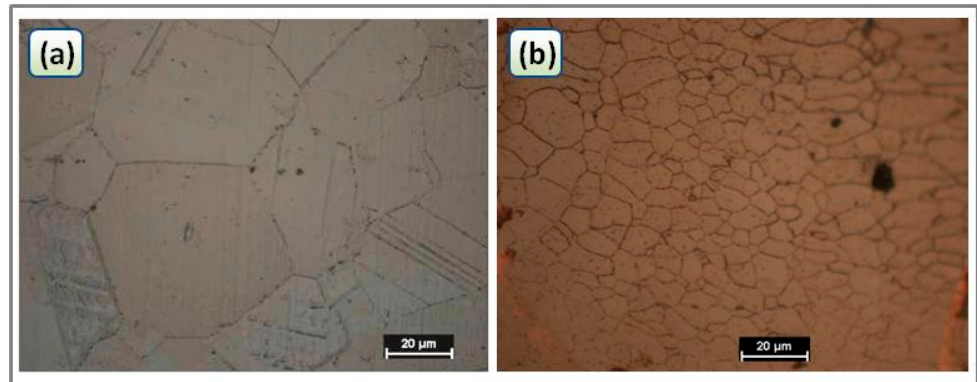
Figure 16. Optical micrographs showing ( a ) base material of 316L stainless steel and ( b ) fine structure in the fusion zone due to the fast solidification.